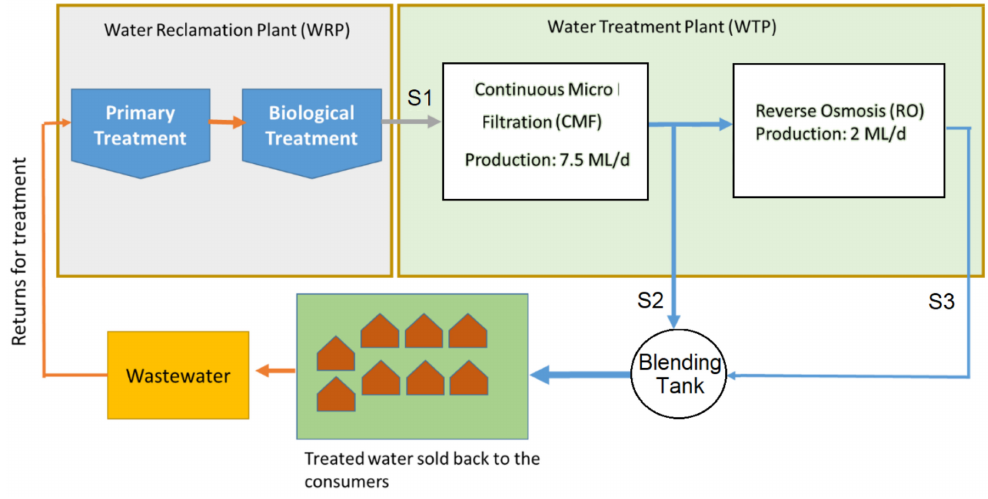
Figure 1. Schematic diagram of a water reclamation plant at Sydney, Australia (modified from